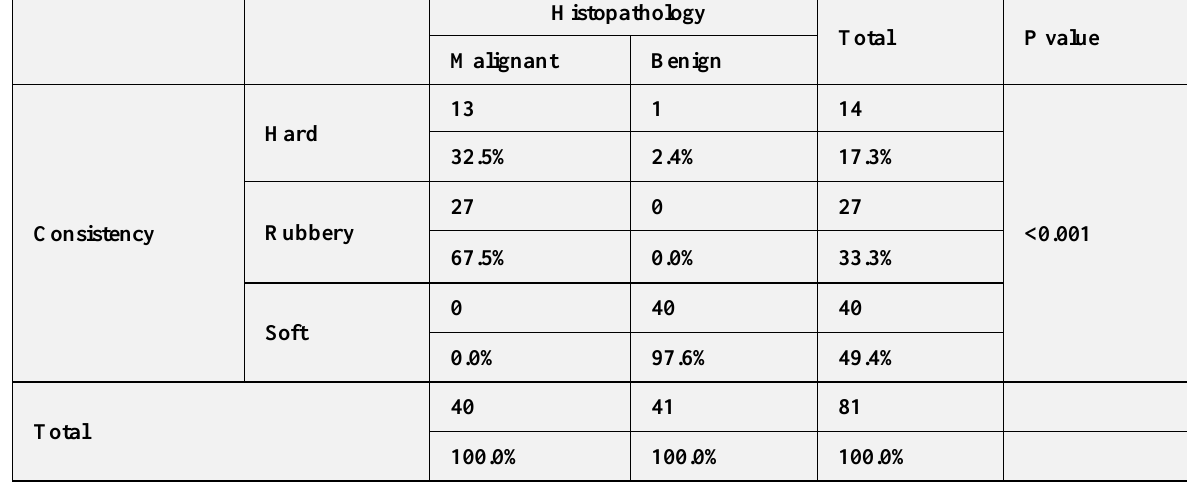
Table (4): Association between consistency of L.Ns and histopathological